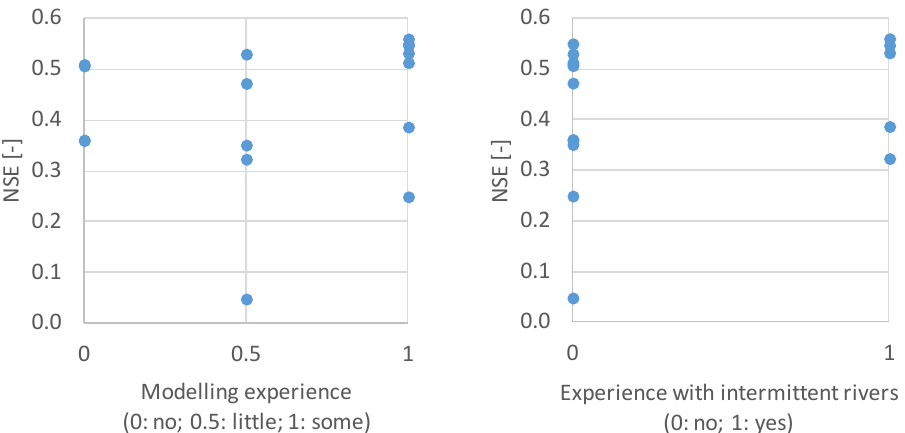
Figure 5. Dependence of model results (Nash-Sutcliffe model efficiency) on the modellers’ experience in relation to model application ( Left ) and the knowledge of the specific characteristics of intermittent catchments ( Right ). For graphical reasons, the results of one modeller are not shown who achieved an NSE value of − 45.9 (little modelling experience, no experience with intermittent rivers).